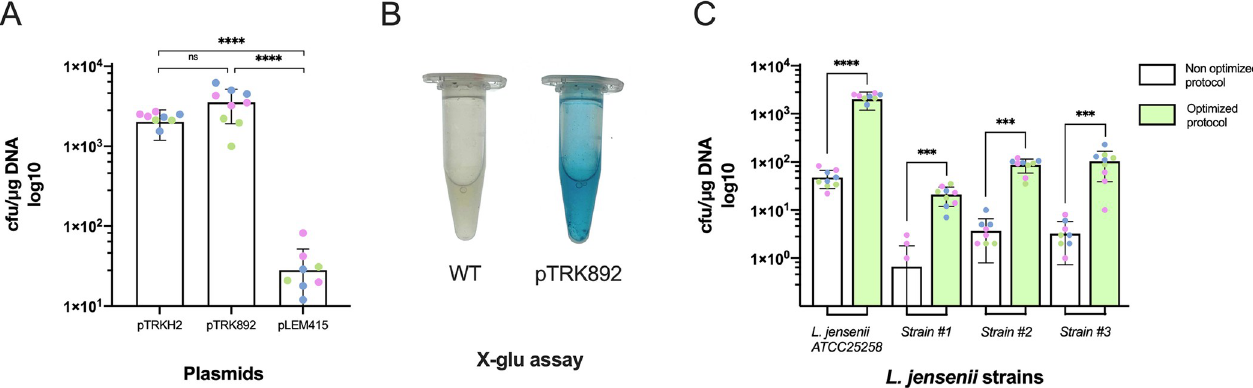
Fig 4. Optimized transformations of various vectors and unrelated L . jensenii strains. A. Transformation efficiency of different plasmids using the optimized protocol. Shown are transformation efficiencies obtained for plasmids pTRKH2, pTRK892 and pLEM415-ldhl-mRFP1. While pTRKH2 and pTRK892 yield similarly high efficiencies, the unrelated pLEM415 yields a measurable but moderate number of transformants. Numbers above bars represent the average number of transformants. B. Beta-glucuronidase assay with Lactobacillus jensenii pTRK892 transformants showed blue coloration after addition of X-GLU substrate. C. The optimized electroporation procedure is efficient across unrelated strains of L . jensenii . Shown is a comparison of transformation efficiencies obtained with the Luchansky [22] and optimized procedure with different clinical isolates. All electroporations were carried with 1.0 μ g of DNA, 3X SMEB, 2% glycine, in 0.2 cm cuvettes and electric parameters as follows: voltage: 12.5 kV/cm, resistance: 400 O , capacitance: 25 μ F. 3 biological replicates of 3 technical replicates were performed on different days (data are shown in S2 Table). Technical replicates are shown in the same color. (Wilcoxon signed-rank test p-value, ns p > 0.05, � p < = 0.05, �� p < = 0.01, ��� p < = 0.001 and ���� p < =